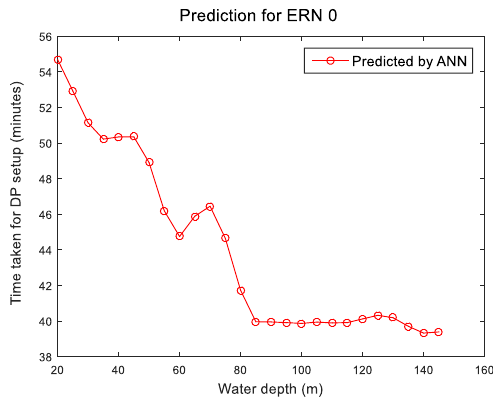
Figure 6. ANN-predicted DP setup time at ERN 0 .